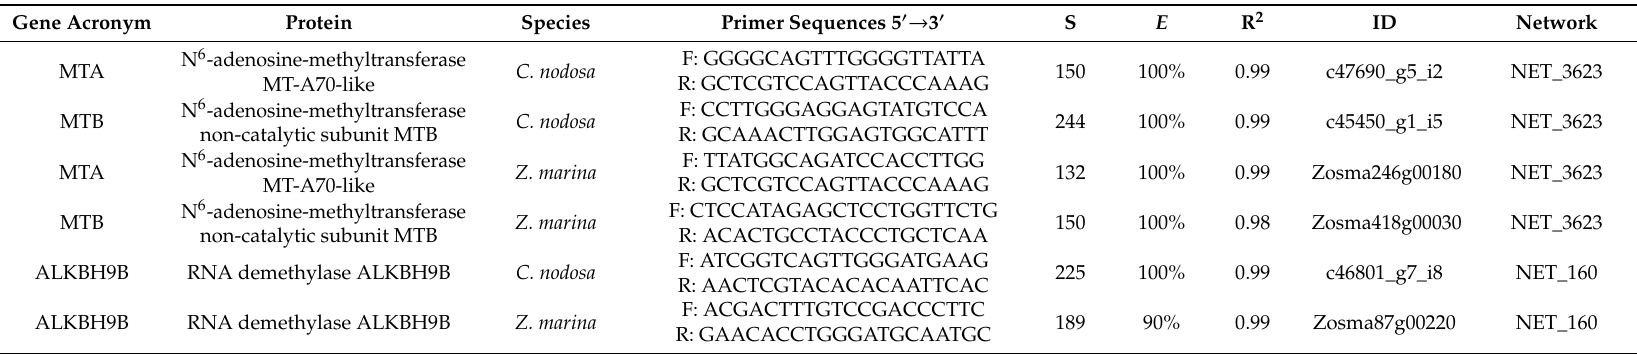
Table 2. List of Genes of Interest (GOIs) in C. nodosa and Z. marina assessed by RT-qPCR. The gene acronym, protein name, species, primer sequences, amplicon size